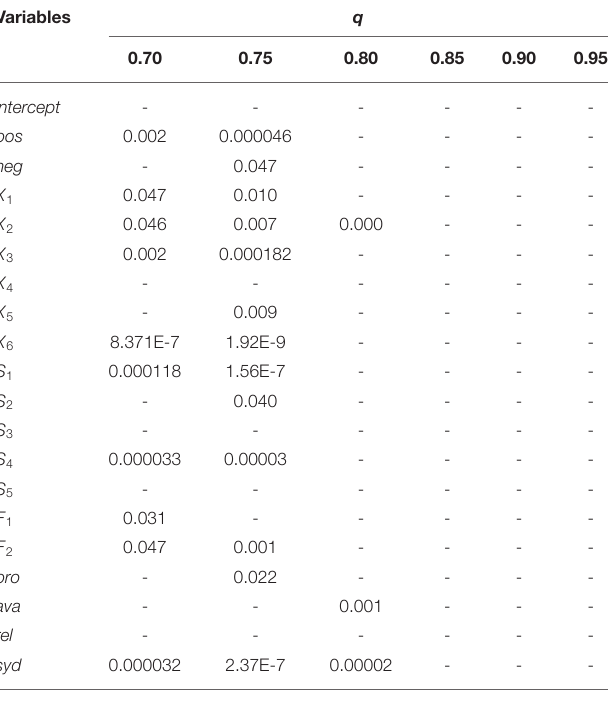
TABLE 8 | Quantile regression coefficient significance Table for each quantile (quantile 0.70 ∼ 0.95).